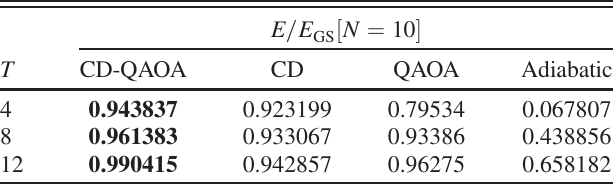
TABLE II. Spin-1 Ising model: comparison of the best-ob- tained energy ratio E=E after optimization for four different GS optimization methods: CD-QAOA, variational CD driving, con- ventional QAOA, and adiabatic evolution, at T ¼ 4 , 8, 12 for N ¼ 10 qutrits, where dim ð H Þ ¼ 3219 . The remaining setup and parameters are the same as in Fig.